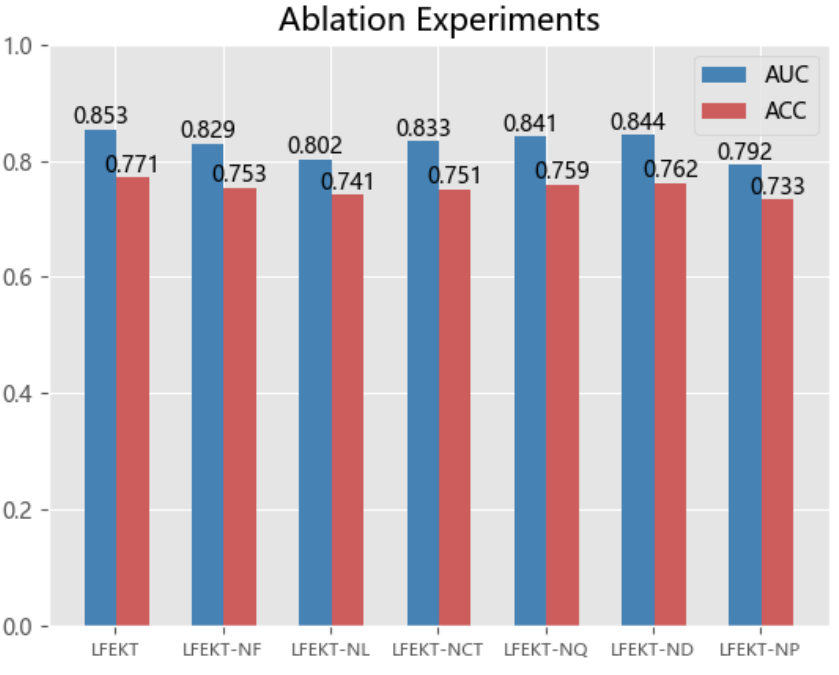
Figure 3. Ablation experiment results on ASSISTChall.